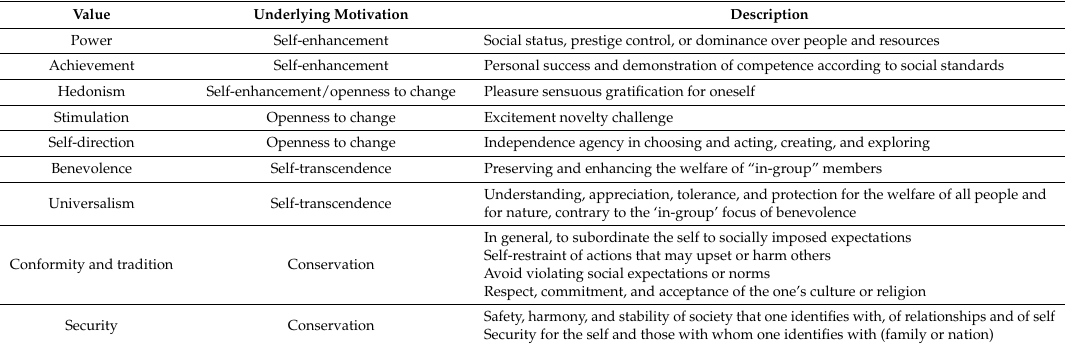
Table 1. Schwartz’s 10 values and underlying motivations (adapted from Schwartz